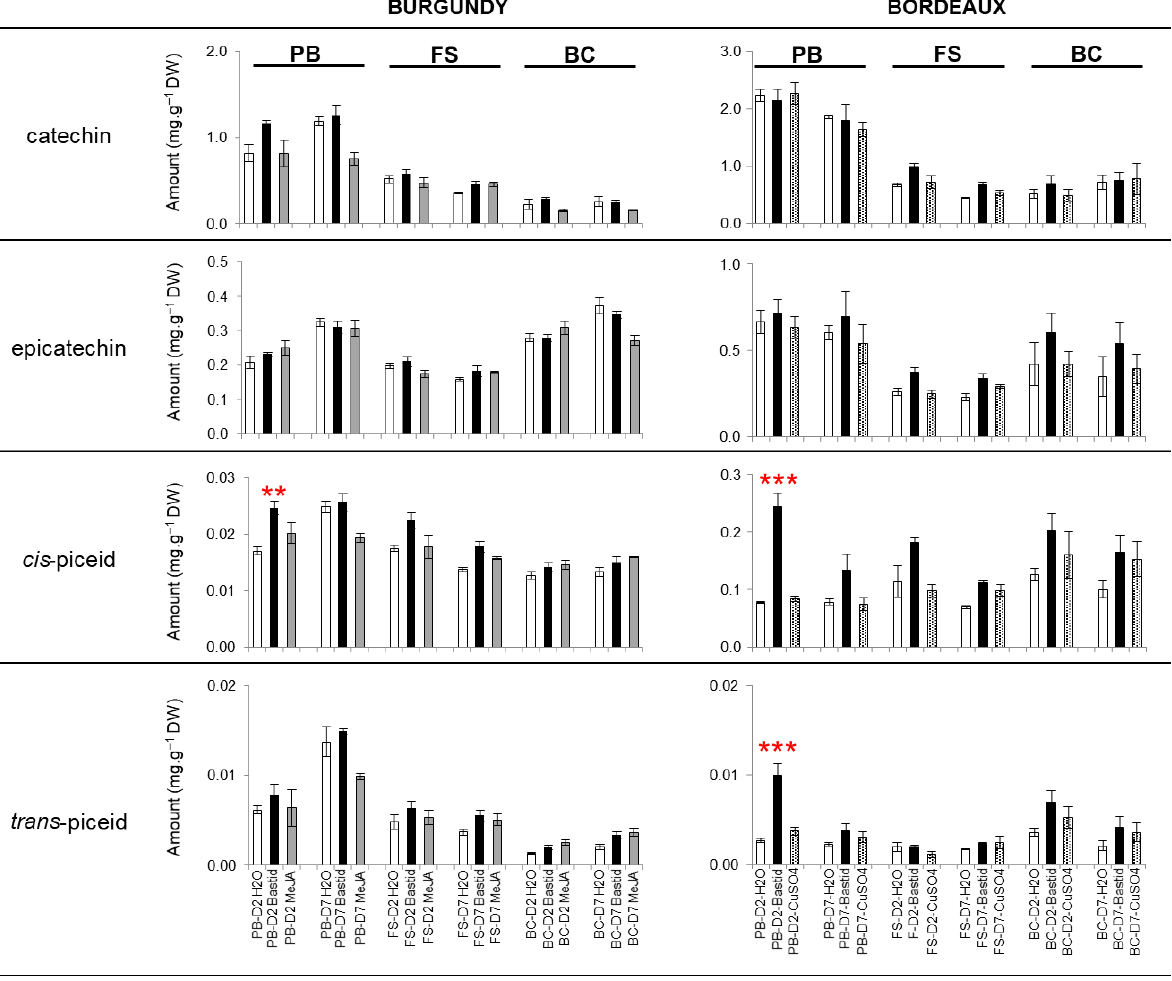
Figure 1. Quantification of phenolics in elicitor-treated grapevine leaves. Experiments were performed in Burgundy (cv. Chardonnay) and Bordeaux (cv. Cabernet franc) vineyards at three phenological stages of grapevine in 2019. Treatments: H 2 O (control) (white), Bastid ® (black), MeJA (grey) and CuSO 4 (dotted grey). Catechin, epicatechin, cis - and trans -piceids were identified and quantified by LC-MS analysis. Concentrations were averaged from 3 replicates and adjusted to the dry weight (DW) of green leaf powder. Phenological stages: pre-blossom: PB, fruit-set: FS and bunch-closure: BC . D2 and D7: samples collected at two- and seven-days post treatment, respec- tively. Significance p value: 0 < *** < 0.001 < ** < 0.01. Among the stilbenes, only the piceids were significantly induced by Bastid ® , at PB- D2 ( cis -piceid in the two vineyards, and trans -piceid in Bordeaux vineyard). MeJA and CuSO 4 did not induce those stilbenes significantly. In 2017 and 2018, the catechin and epi- catechin were accumulated the most and in similar amounts, regardless of Bastid ® treat- ment or the phenological stage of grapevine. The cis- and trans -piceids were also signifi- cantly accumulated in the Bastid ® -treated leaves and more so in the Bordeaux vineyard (Figure S1). Stilbene production was not induced by elicitors, except for Bastid ® on D2. 3. VOC Emission Analysis 3.1. Determination of the Optimal Sampling Method Several conditions of VOC collection were assessed and large amounts of data were generated (detailed in the Experimental section, Section 7 and Table S2). To validate our approach for measuring VOCs in the field, we first compared the profiles of the VOCs